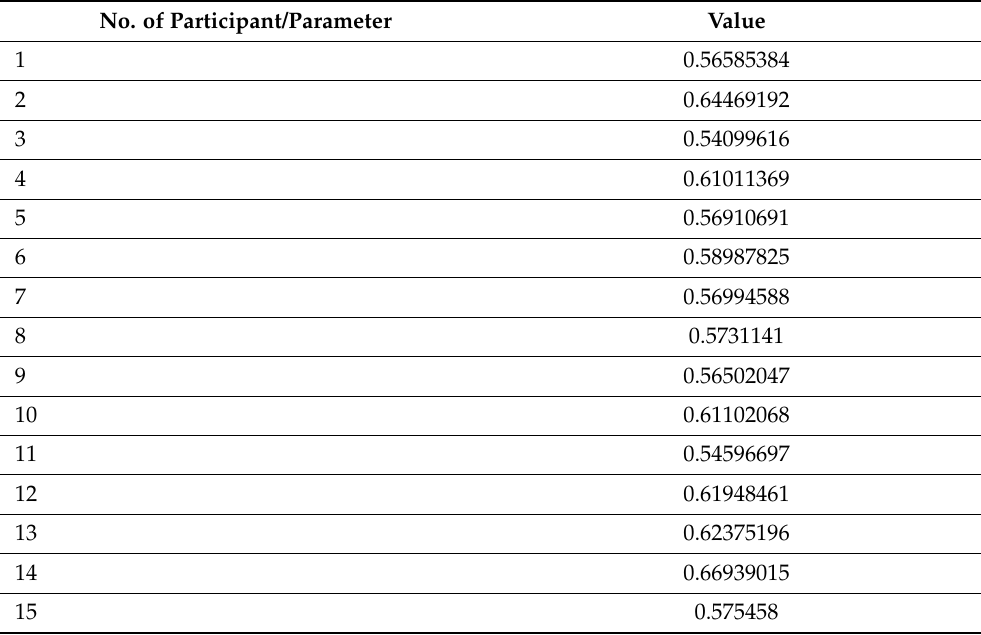
Table 4. Fuzzy model outcomes for studied Group